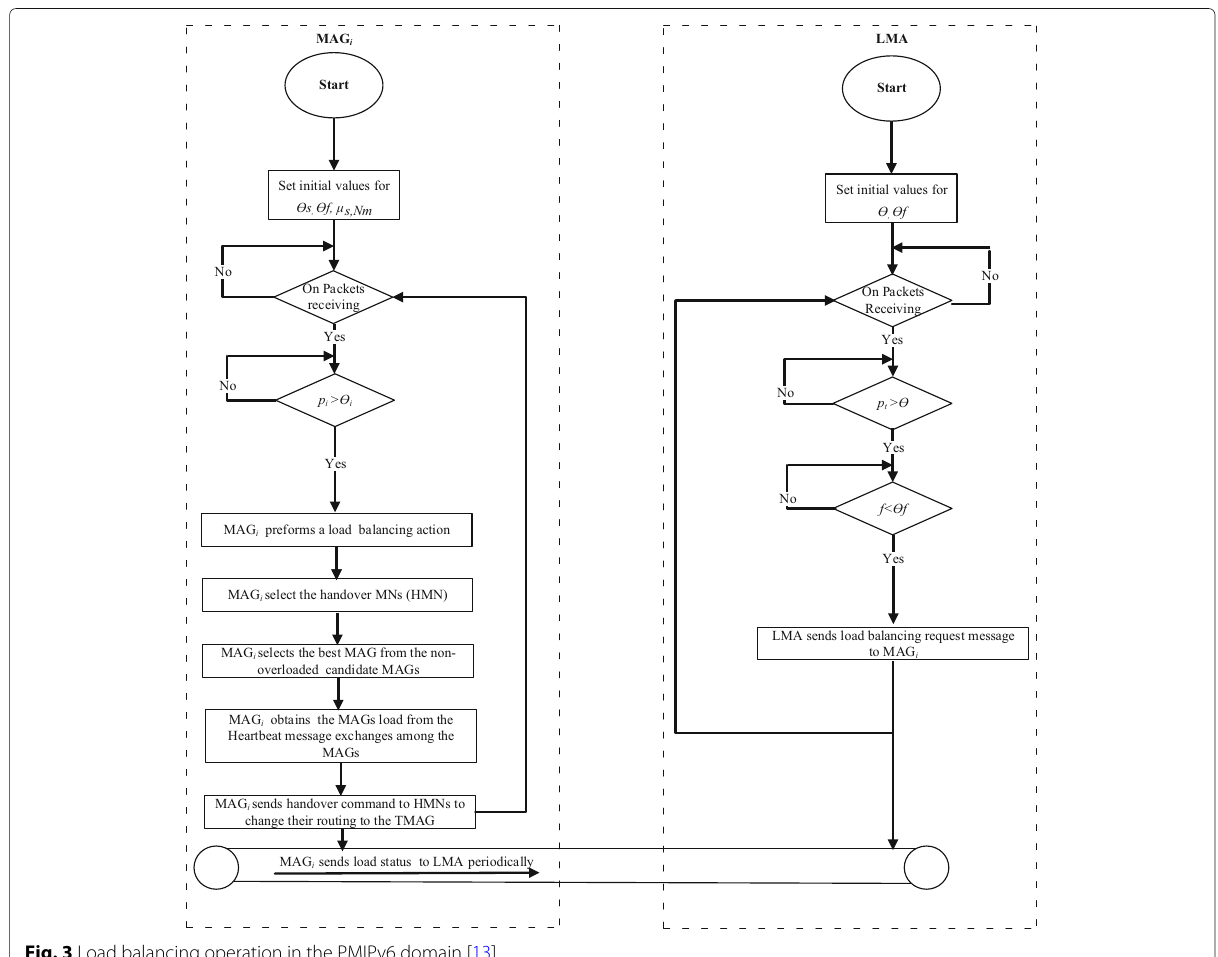
Fig. 3 Load balancing operation in the PMIPv6 domain